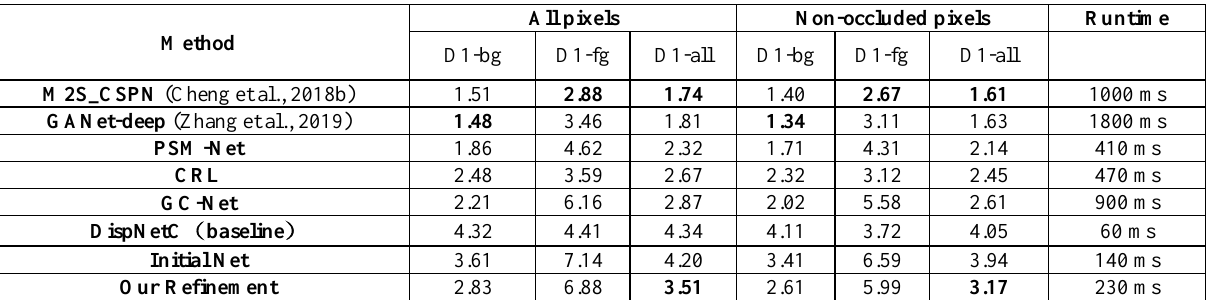
Table 3 Comparison results of our model with other methods on KITTI2015